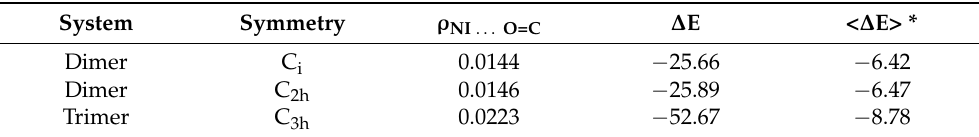
Table 2. Complexation energy, ∆ E (kcal/mol), average complexation energy, < ∆ E> (kcal/mol), and electron density at bond critical point, ρ (a.u.), for cyclic dimers and trimer of the model system, ((HOOC) 2 -C 6 H 2 -(NHI) 2